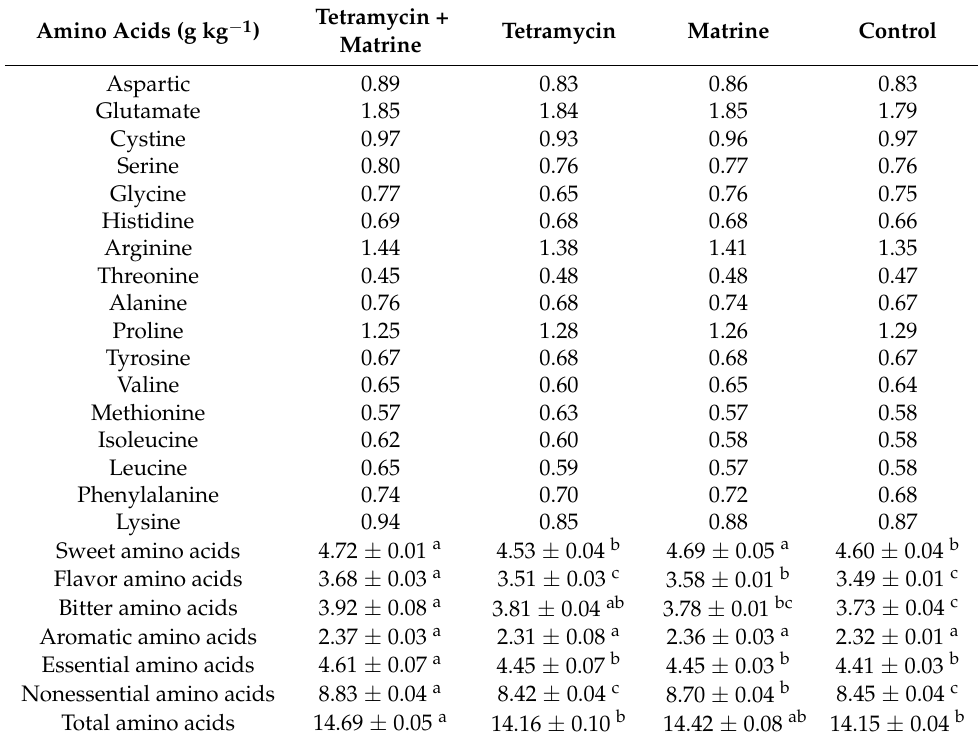
Table 7. The effects of tetramycin and matrine on amino acids of kiwifruit fruits. Tetramycin + Amino Acids (g kg − 1 )